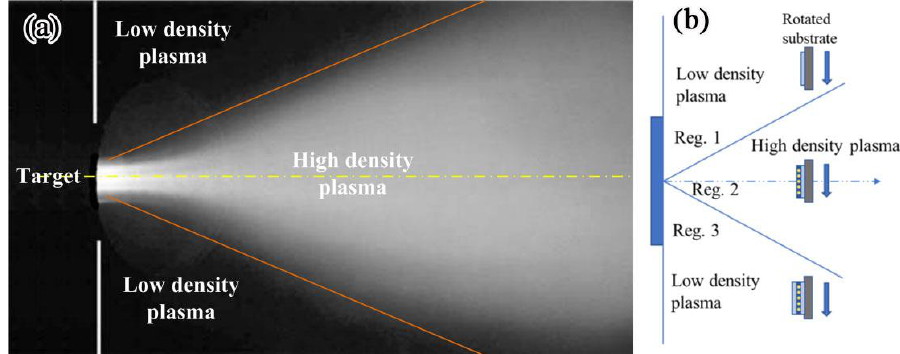
Figure 5. Plasma pluming from the flange-mounted source into the chamber ( a ), and a schematic diagram of the deposition of the layered nanoparticle coating ( b ).